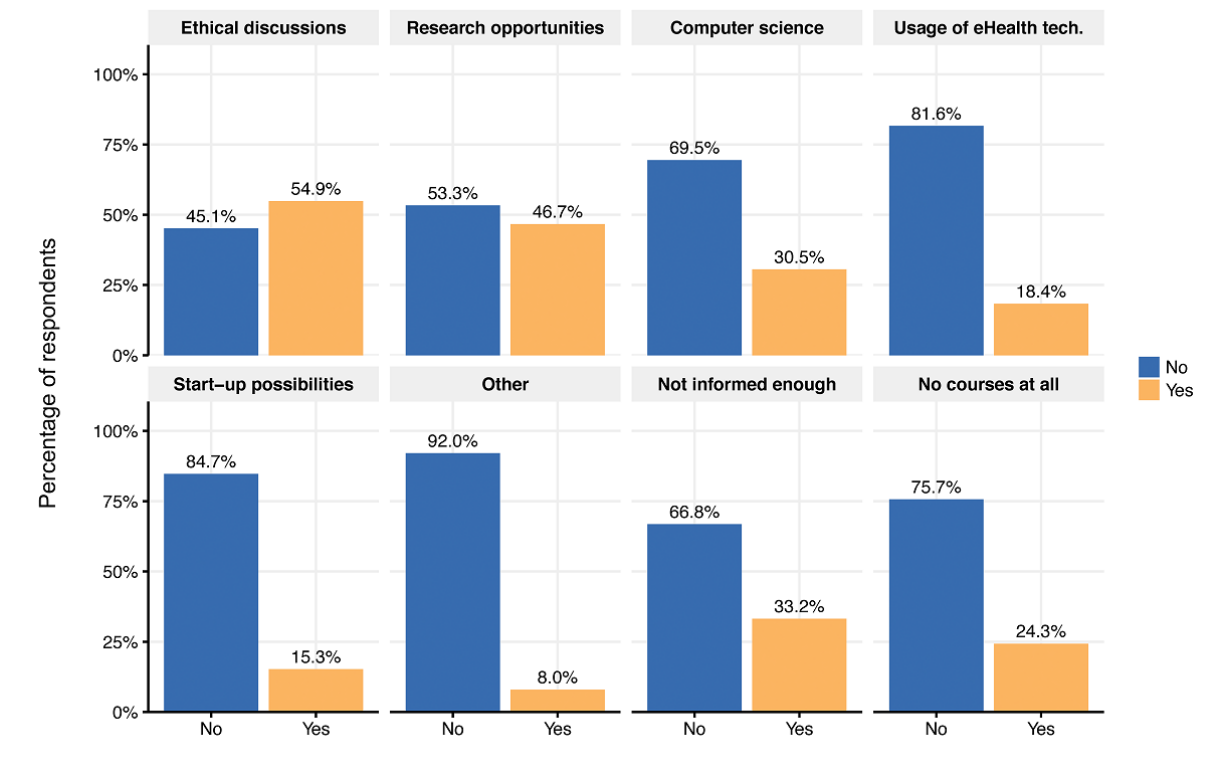
Figure 4. Overview of eHealth-related topics provided by the respondents’ faculty (ie, response to the question: "What eHealth-related topics does your faculty provide courses